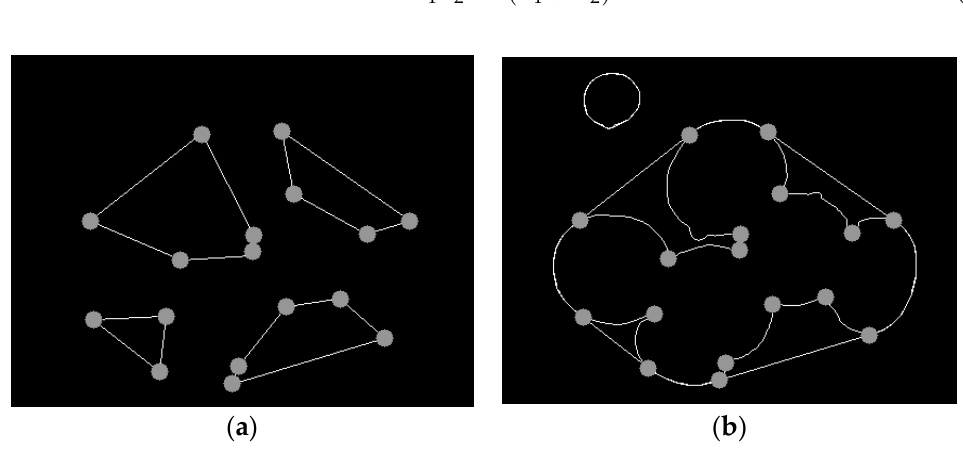
Figure 7. Vertex detection. ( a ) Corner detection; ( b ) corner display on the outline.